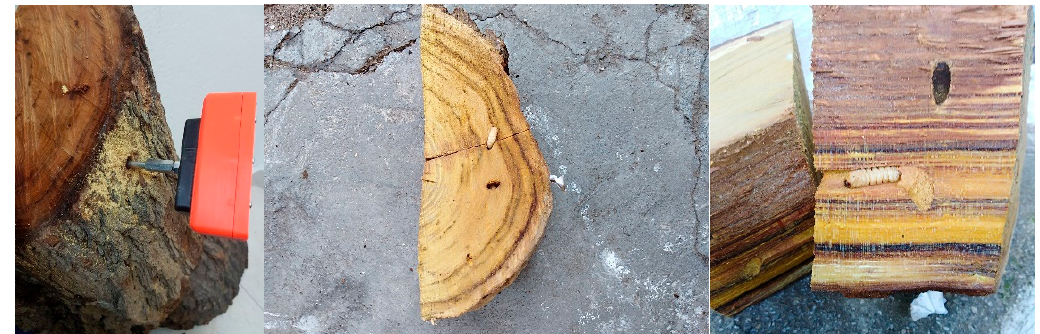
Figure 9. A X. chinensis positive case in a mulberry trunk. ( left ) The sensor mounted horizontally in a suspicious trunk in the laboratory, ( middle and right ) two alive larvae have been found after cutting the suspicious trunk in slices. The larvae tunnels can be seen in the right picture.